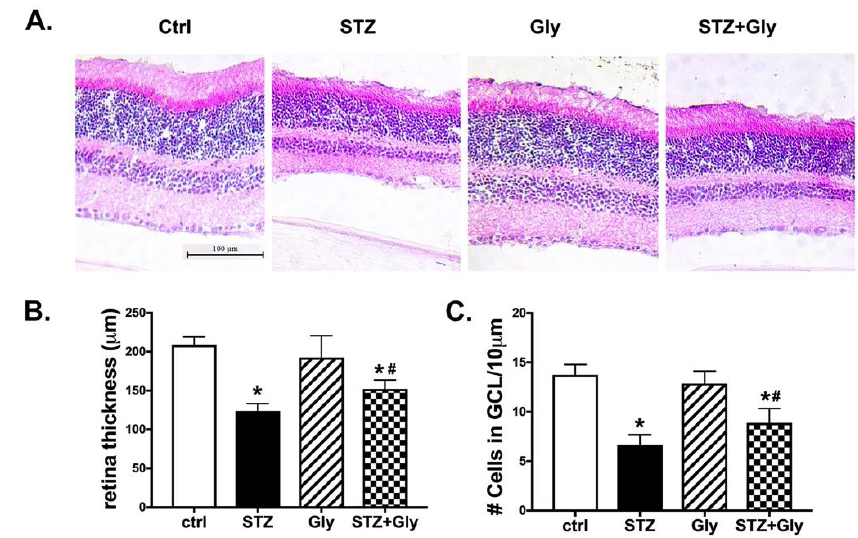
Figure 2. Hematoxylin and eosin for neuronal changes at two months of treatment. ( A ) Are representative images from control mice (Ctrl), control mice treated with glycyrrhizin (Gly), diabetic mice (STZ), and diabetic mice treated with glycyrrhizin (STZ + Gly). ( B ) Shows quantification of retinal thickness, and ( C ) is data on cell numbers in the ganglion cell layer (GCL). * p < 0.05 vs. ctrl, # p < 0.05 vs. Diabetes. n = 5 for each group.